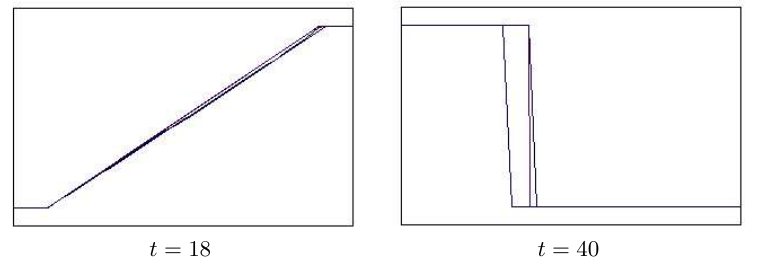
Figure 7. Numerical solution for the jumping advection method for 2 initial data ( (cid:13) = 0 : 5; 0 : 9 )